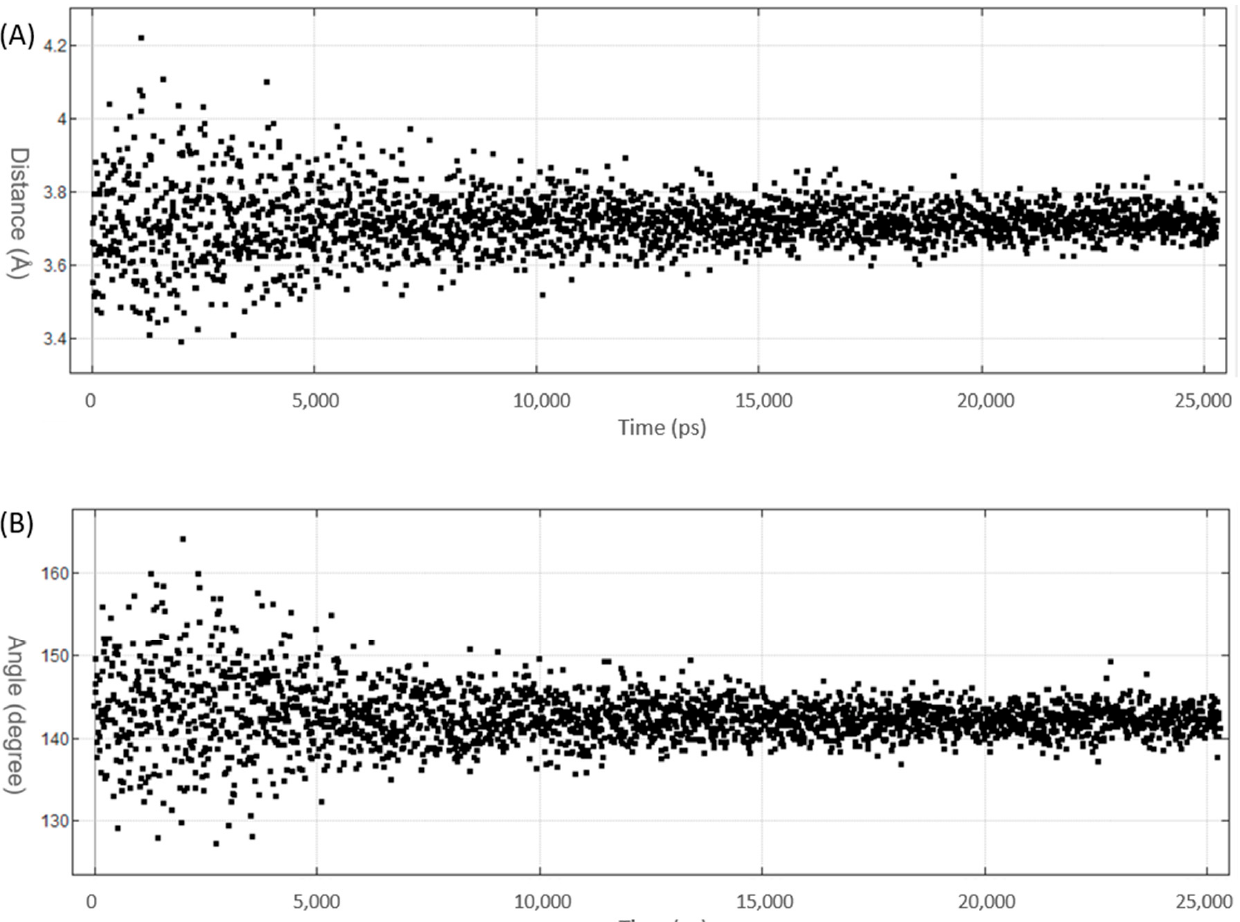
Figure 4. Plot of XB parameters of MD simulation trajectory of 5-iTU with Haspin receptor: ( A ) XB distance (I ··· C α ) and ( B ) XB angle (<C-I ··· C α ). The RMSD plot is given in Supporting Information (Figure S1).